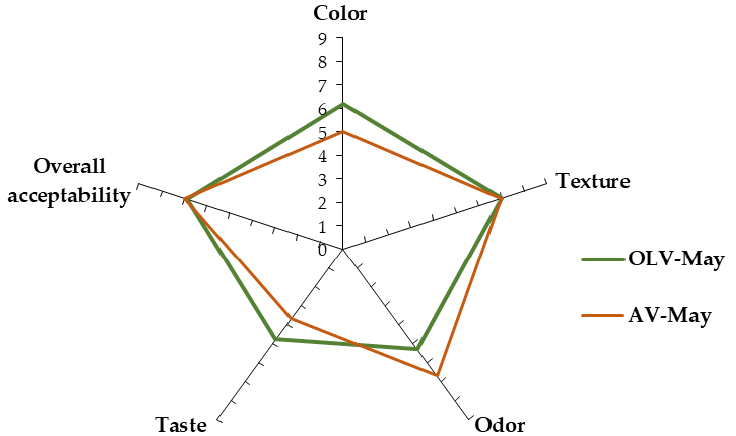
Figure 1. Spider plot median score (MS) of the 9-point hedonic scale of the sensory analysis of the mayonnaise samples prepared with olive leaf vinegar (OLV-May) and alcoholic vinegar (AV-May).